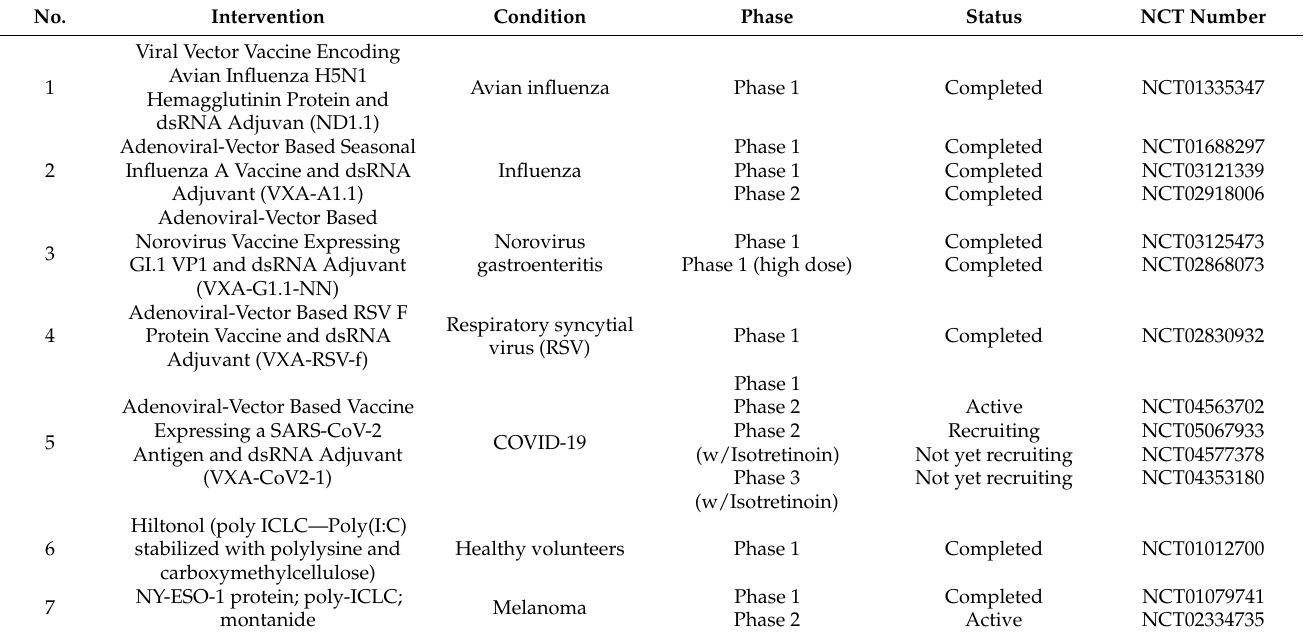
Table 4. Ongoing and completed clinical trials exploring dsRNA as